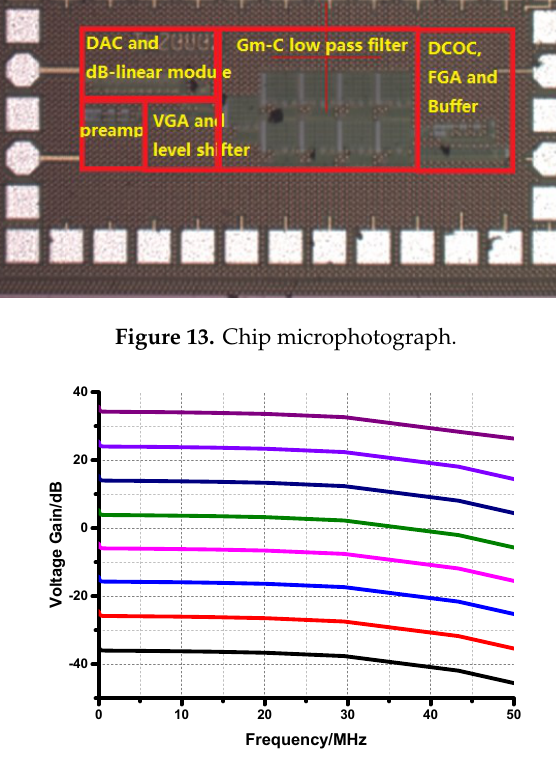
Figure 14. Measured voltage gain tuning response of the proposed chip with LPF bypassed (PGA + buffer).